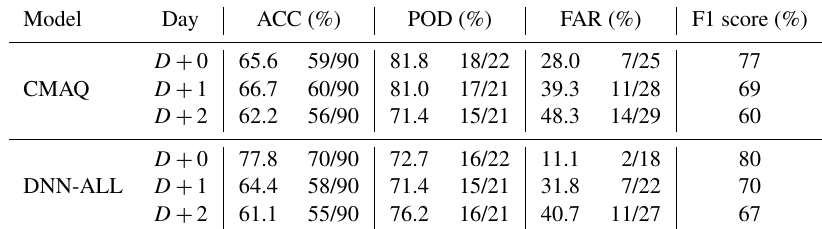
Table 7. Categorical forecast scores of the performance of the CMAQ and DNN-ALL models.